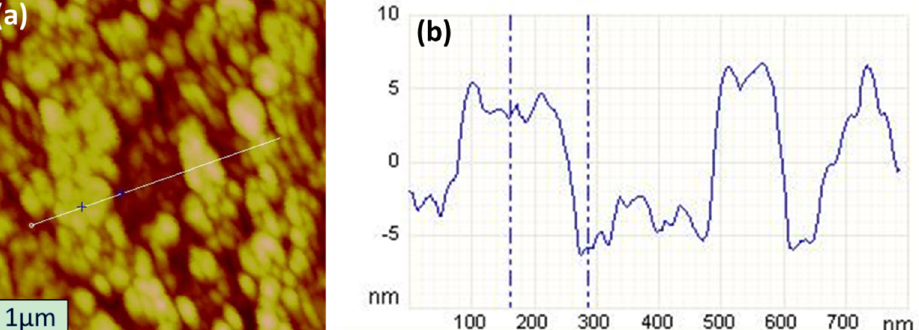
Figure 3. ( a ) AFM images of N-doped NiO thin films at room temperature and ( b ) thickness profile along the line in ( a ) across region A and region B.